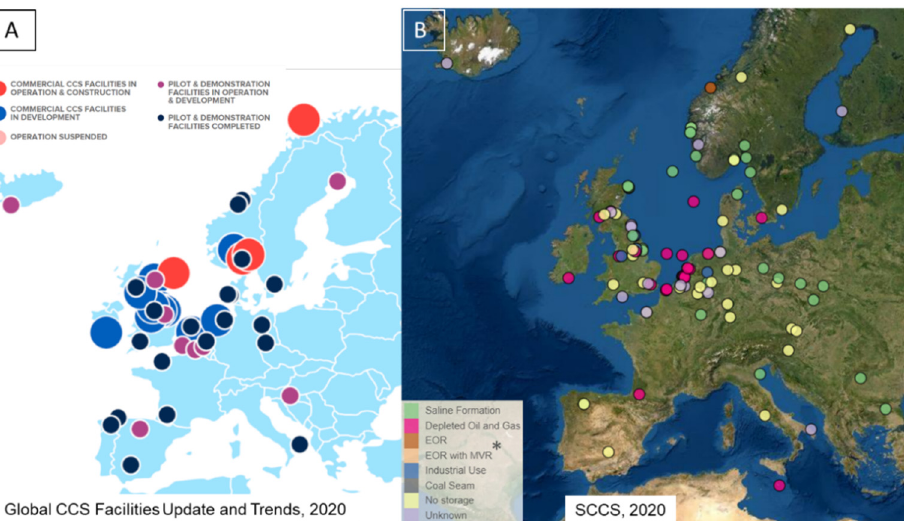
Figure 1. European map of CCS facilities completed, in development and ongoing. In ( A ), the overview of Global CCS facilities in 2020 classified by size of the project: commercial (large) scale or pilot scale. The status of these projects is represented by the color bubble. Map ( B ) indicates the storage status of all CCS projects regardless of their size. Yellow circles are projects without geological storage of CO 2 . (* EOR = enhanced oil recovery; MVR = monitoring, verification and reporting).